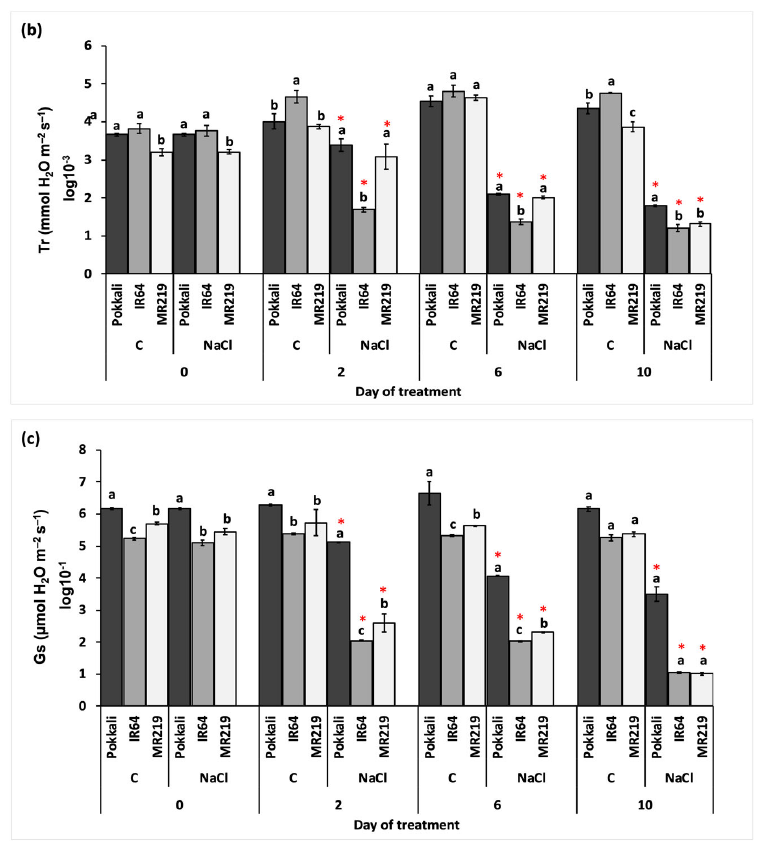
Figure 2. Salinity effect on ( a ) photosynthesis rate (Pn), ( b ) transpiration rate (Tr), and ( c ) stomatal conductance (Gs) at four different time points. The small letter at the top of the bar indicates significant differences between varieties at the same time point, whereas (*) indicates significant differences in a variety between control and salinity-treated plants using the DNMRT analytical method with a p ‐ value of 0.05. Error bar: Standard deviations (SD) of the means.